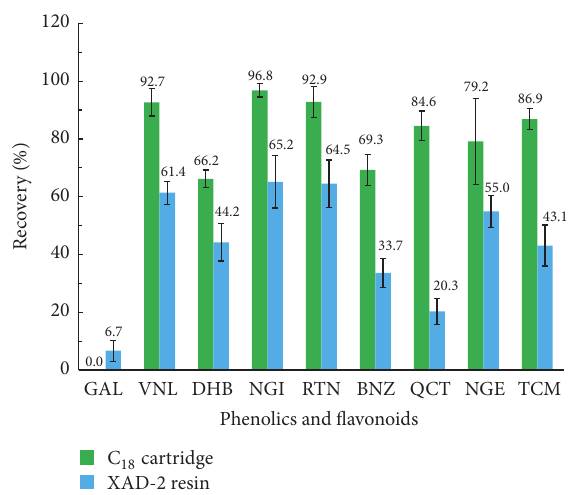
Figure 2: Recovery of polyphenols from artificial honey using C 18 cartridges and Amberlite XAD-2 resin extraction. Gallic acid (GAL), benzoic acid (BNZ), dihydroxybenzoic acid (DHB), narin- genin (NGE), naringin (NGI), rutin (RTN), quercetin (QCT), trans- cinnamic acid (TCM), and vanillic acid (VNL).